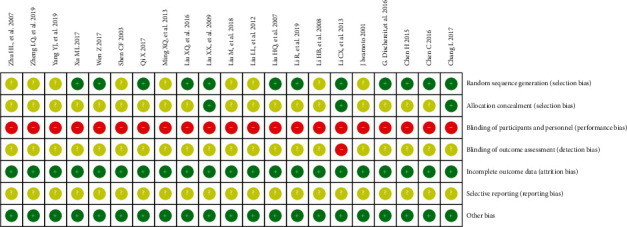
Risk of bias summary for each included study.